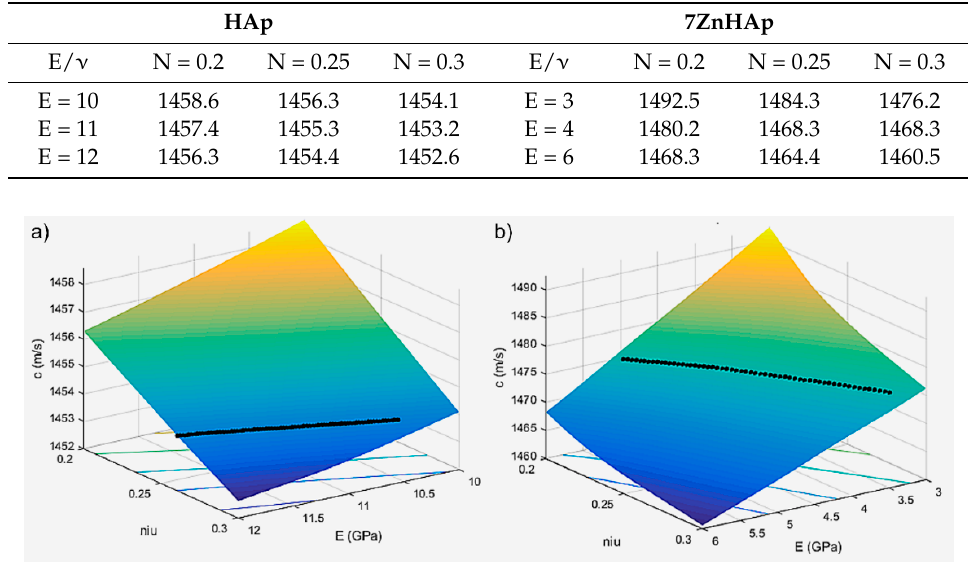
Figure 10. Ultrasonic velocity through the HAp ( a ) and 7ZnHAp ( b ) dispersions according to Young (E) module values. The black lines indicate the interpolated values.